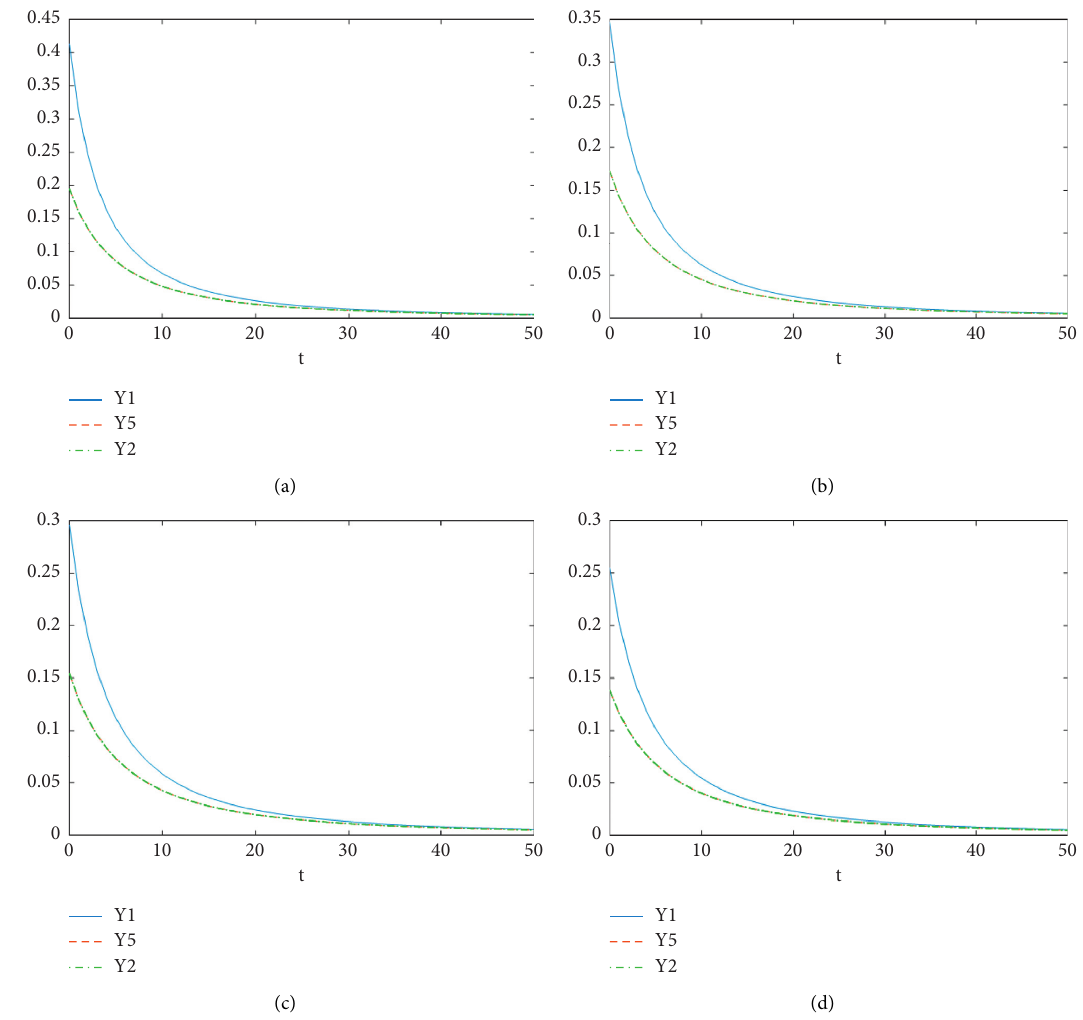
Figure 4: Balanced carbon emissions before and after the integration of Situation I and Situation II ( s β � 0 . 4. (c) β � 0 . 6. (d) β � 0 .